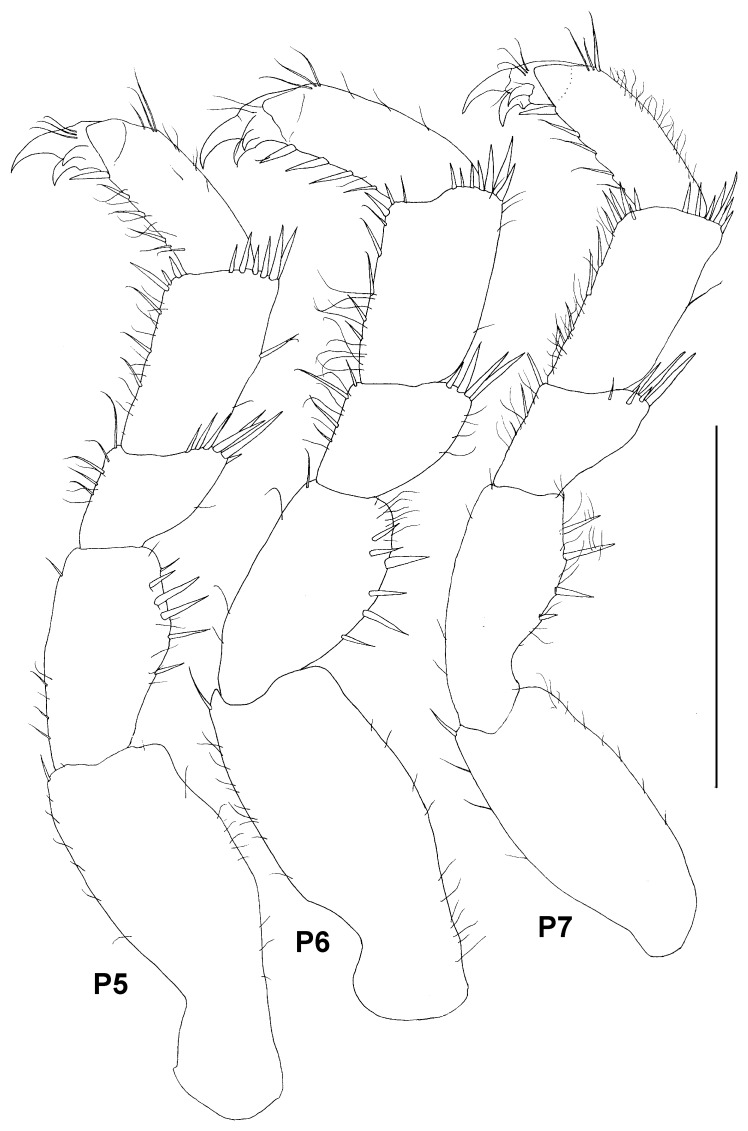
Paratype ZMH K-44090, male, pereopods 5–7, scale – 0.5 mm.